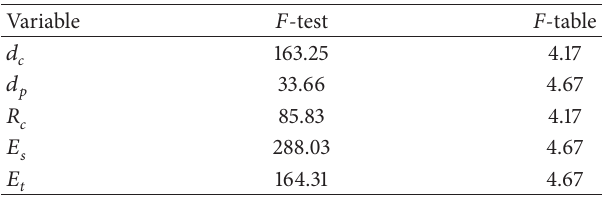
Table 6: Results of the F -test for the analysis of variance. Variable F